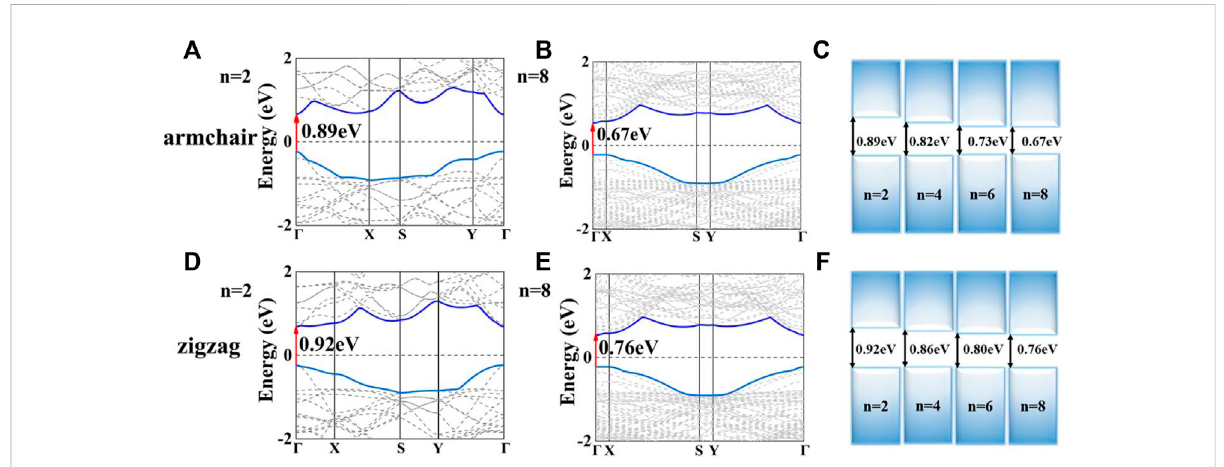
FIGURE 1 (A,B) BandstructureofthearmchairofSb respectively. (D,E) Bandstructureofthezigzag Sb 2 /Bi 2 LHSsand Sb 8 /Bi 8 LHSs, respectively; (F) BandgapofthezigzagSb/Bi LHSundernfrom2to 8,